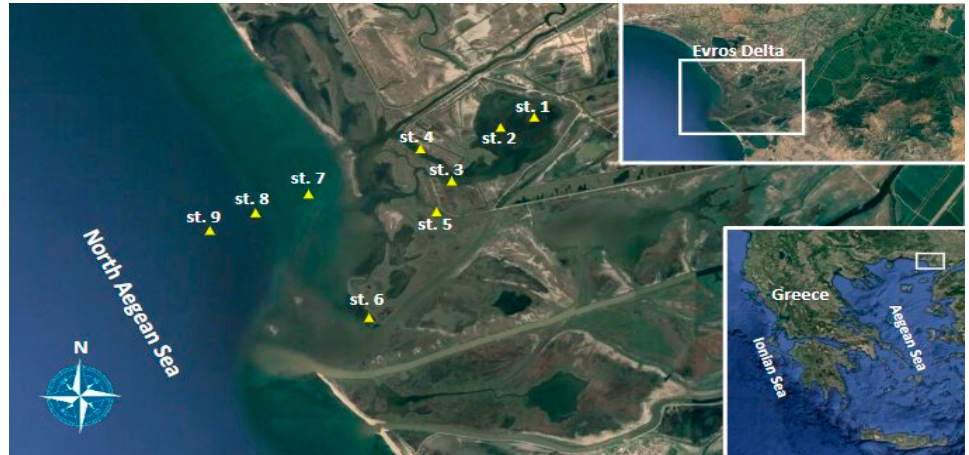
Figure 1. Map of the study area indicating the sampling stations in Monolimni Lagoon, Evros River estuary (st. 1–st. 6), and in the adjacent coastal area (st. 7–st. 9). Stations’ depth: st. 1 = 0.5 m, st. 2 = 0.5 m, st. 3 = 0.5 m, st. 4 = 2.5 m, st. 5 = 0.5 m, st. 6 = 0.5 m, st. 7 = 1 m, st. 8= 3 m, st. 9 = 6 m.